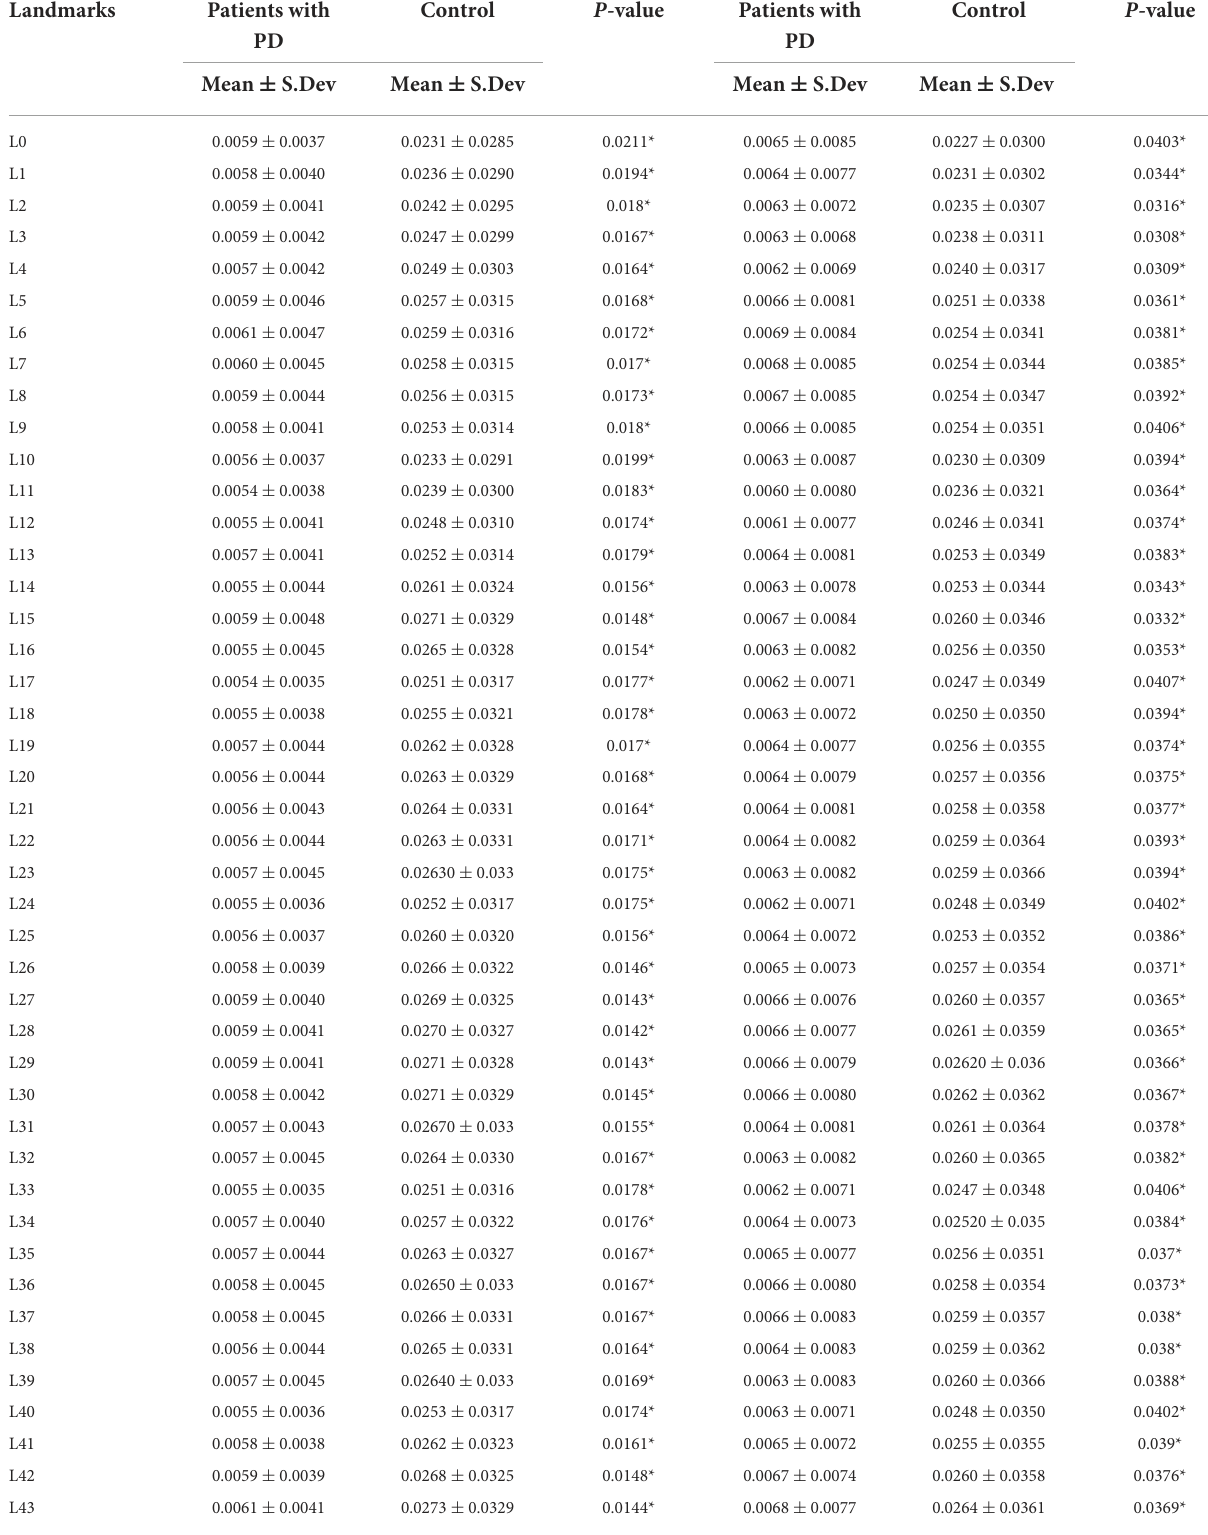
TABLE 2 Comparison of landmark movements in groups due to syllable